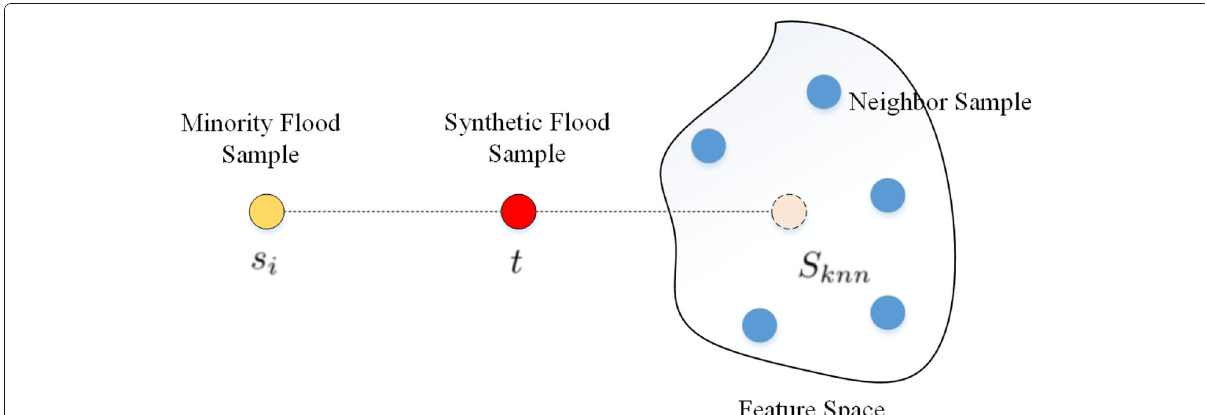
Fig. 2 Illustration of our proposed SMOTE algorithm. Detailed legend: The core idea to generate virtual samples is shown in Fig. 2, where we generate new sample in minority flood pattern s i , named as minority sample, with synthetic sample t , which is created based on feature values of the k nearest neighbor samples forming a set of samples named as S knn